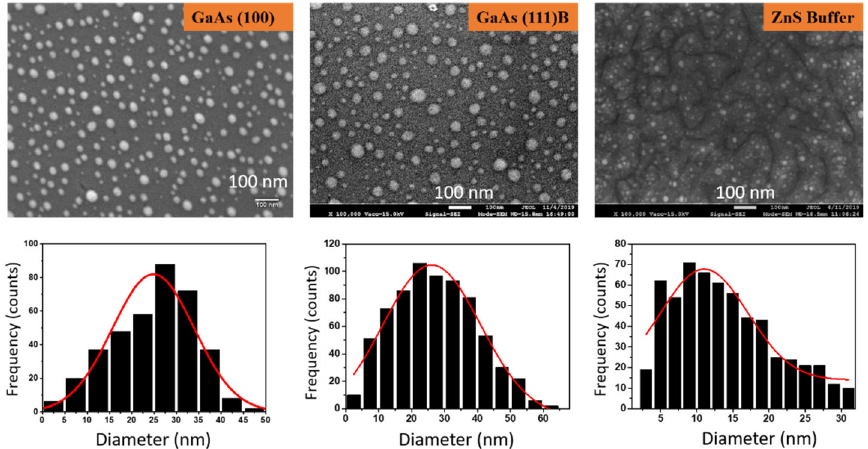
Figure 3. SEM images and statistics of gold droplets deposited and dewetted on GaAs (100), GaAs (111)B, and ZnS/GaAs (111)B substrates. (111)B, and ZnS/GaAs (111)B